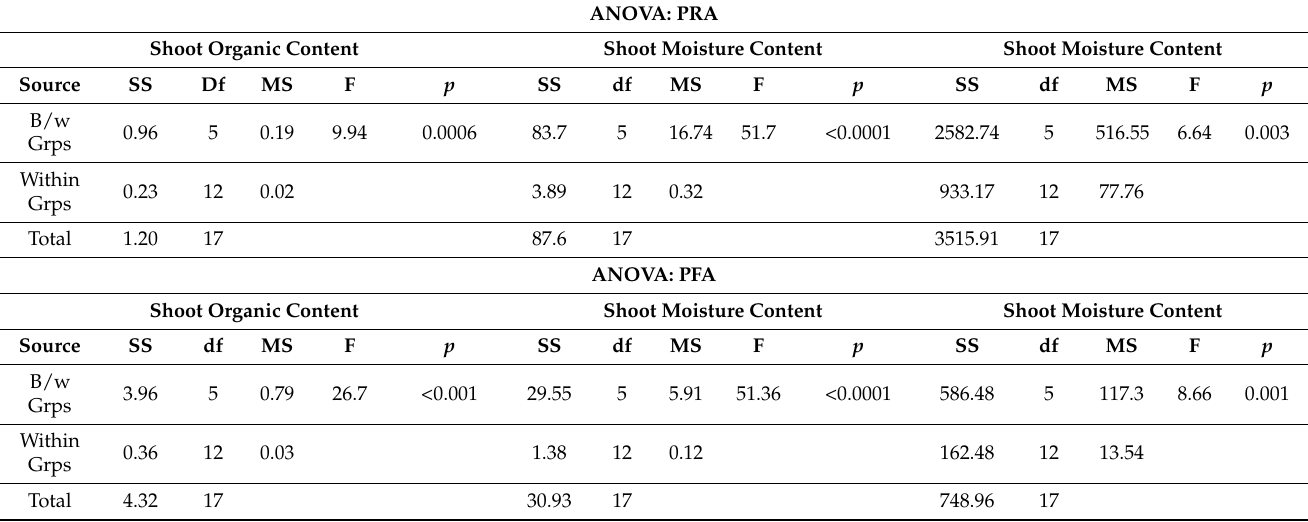
Table 6. ANOVA for the efficacy of ANE via PFA and PRA experiments on biomass accumulation in shoots. ANOVA: PRA